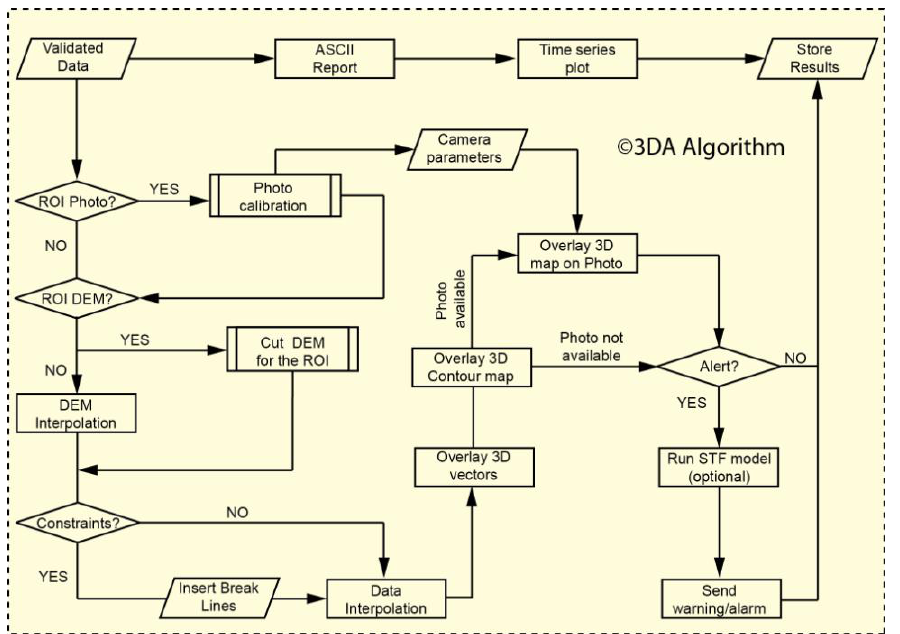
Figure 4. Detailed flow chart of the ©3DA Algorithm as implemented in Matlab ®